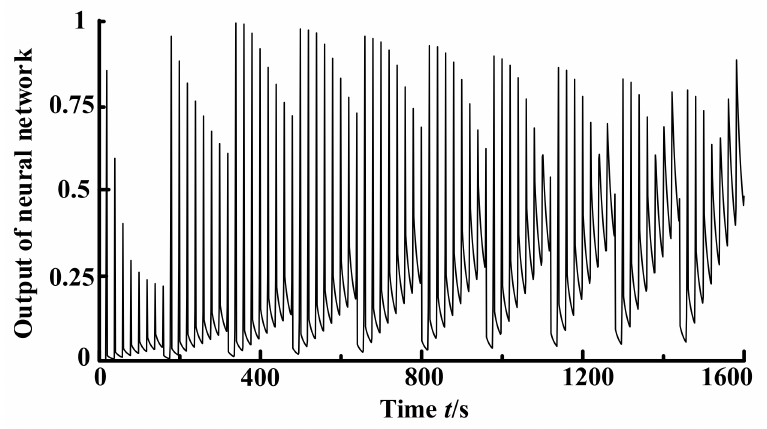
Figure 8. Output of the neural network after data processing.